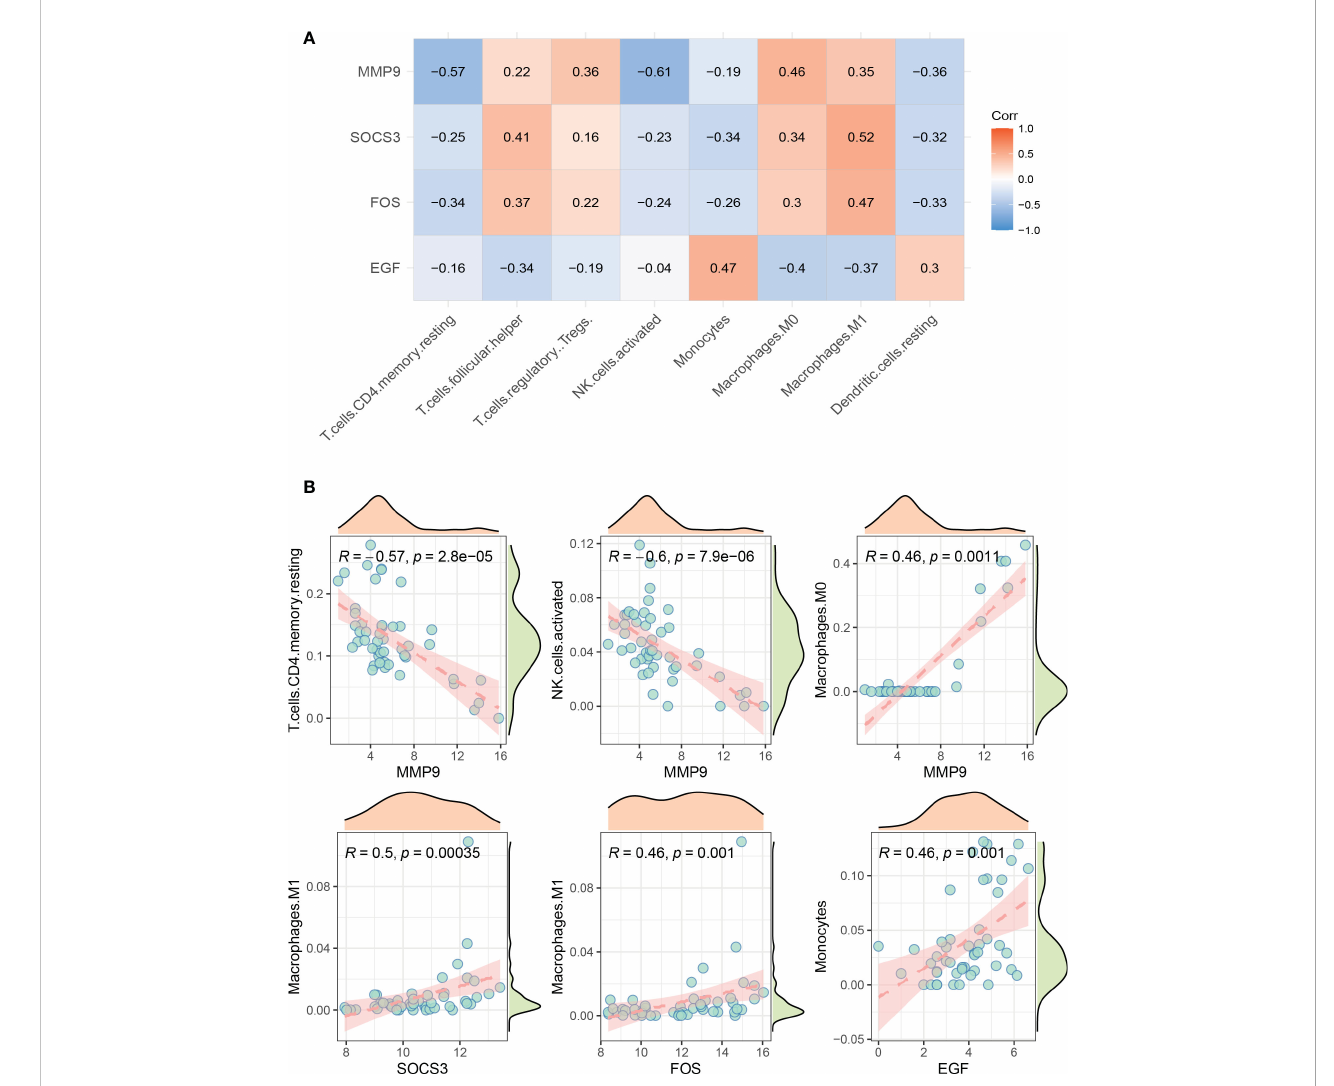
FIGURE 6 Visualization of correlation between hub genes and in fi ltrating immune cells. (A) Correlation between 4 hub genes and 8 signi fi cantly different immune cells. Red represents positive correlation, blue represents negative correlation. (B) Signi fi cantly correlated hub genes and immune cells were screened by adjusted p-value < 0.05.